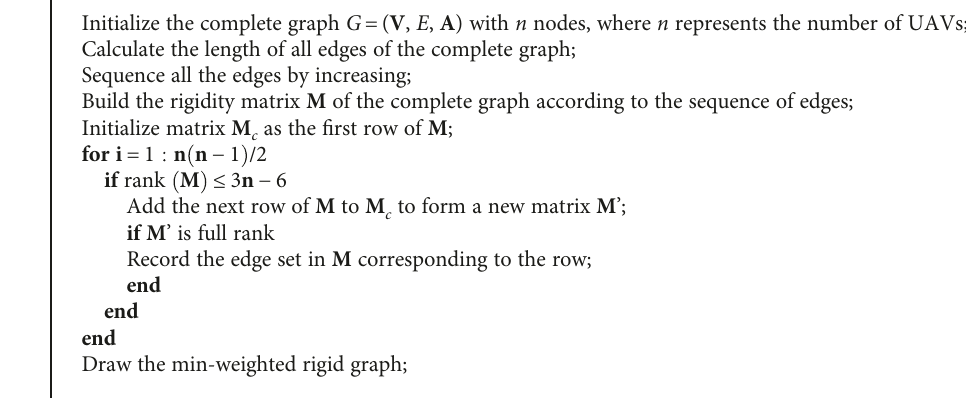
Algorithm 1: Generation of the min-weighted rigid graph in 3D space.